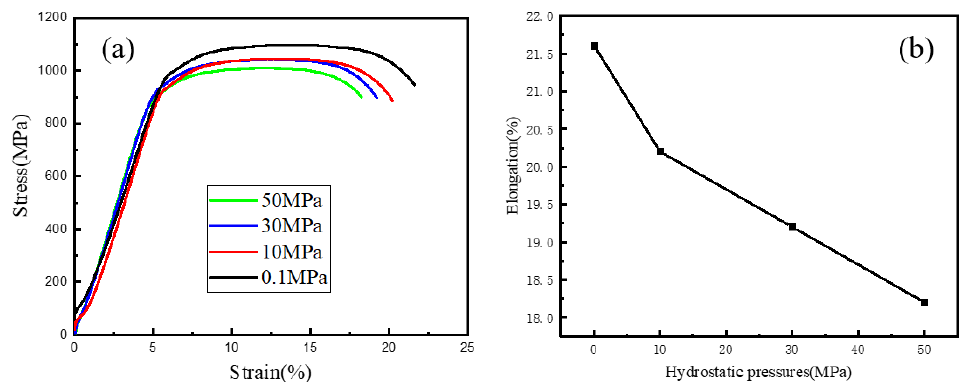
Figure 9. The stress–strain curves ( a ) and elongation ( b ) of Ti6Al4V alloy after 1 h charging under different HPs.